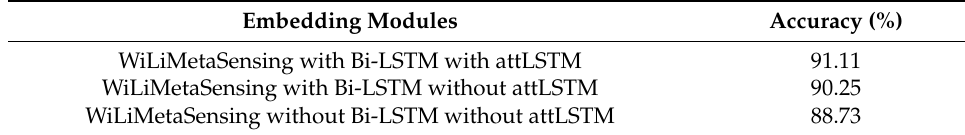
Table 3. The recognition accuracy with different embedding modules.